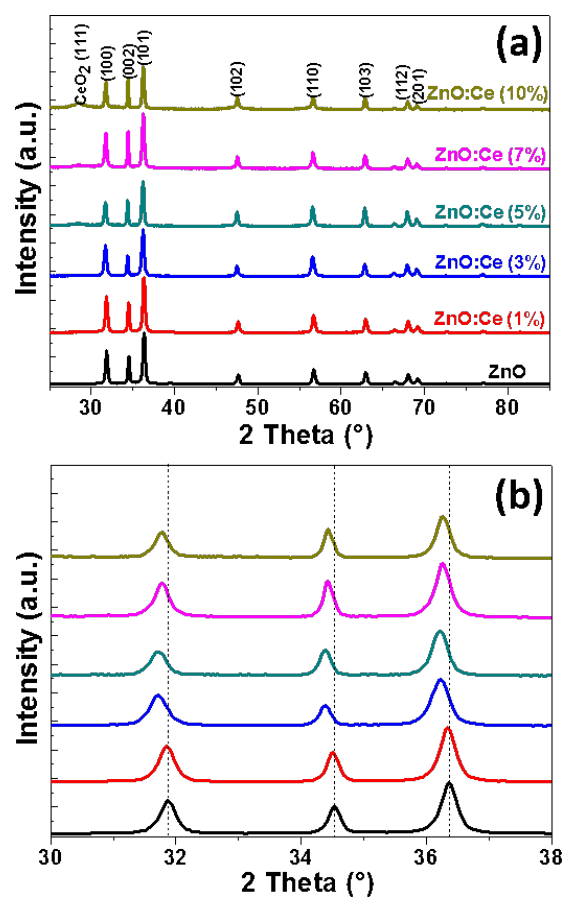
Figure 1: (a) XRD patterns of ZnO and Ce-doped ZnO rods and (b) magnification from 30 to 38°.